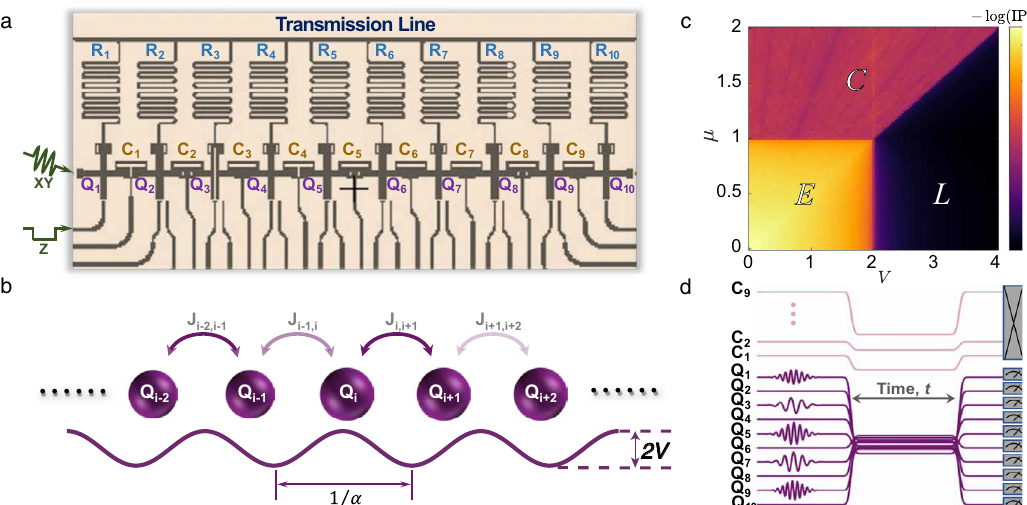
Fig. 1 Experimental setup. a Circuit diagram of the superconducting processor, consisting of ten transmon qubits, Q 1 – Q 10 , and nine couplers C 1 – C 9 , each of which is placed between every two nearest-neighbor qubits. b Schematic representation of the GAAH model with both the on- site and off-diagonal quasi-periodic modulations. The darkness of the double-headed arrows above the qubits indicates the variation of nearest-neighbor coupling strength J i , i + 1 , and the sinusoidal curve below the qubits shows the on-site potential h j with modulation amplitude V . c Phase diagram of the GAAH model, divided into extended ( E ), localized ( L ), and critical ( C ) phases. The heatmap shows the inverse participation ratio (IPR) averaged over all eigenstates and 100 con fi gurations of δ for system size L = 1000. d Experimental pulse sequences for observing localization properties of the GAAH